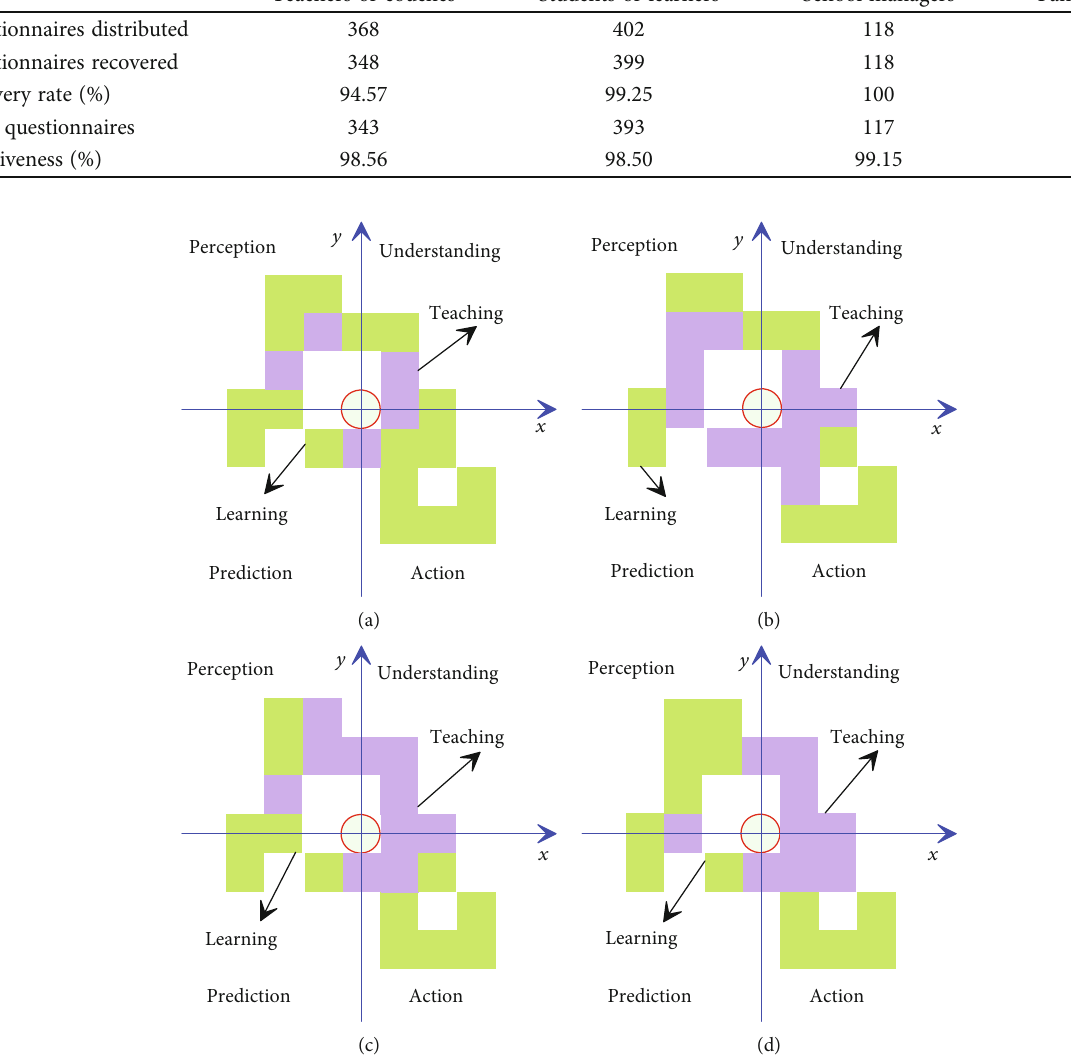
Table 3: Statistics of questionnaire distribution and recovery in each education system of Taiyuan City. Items